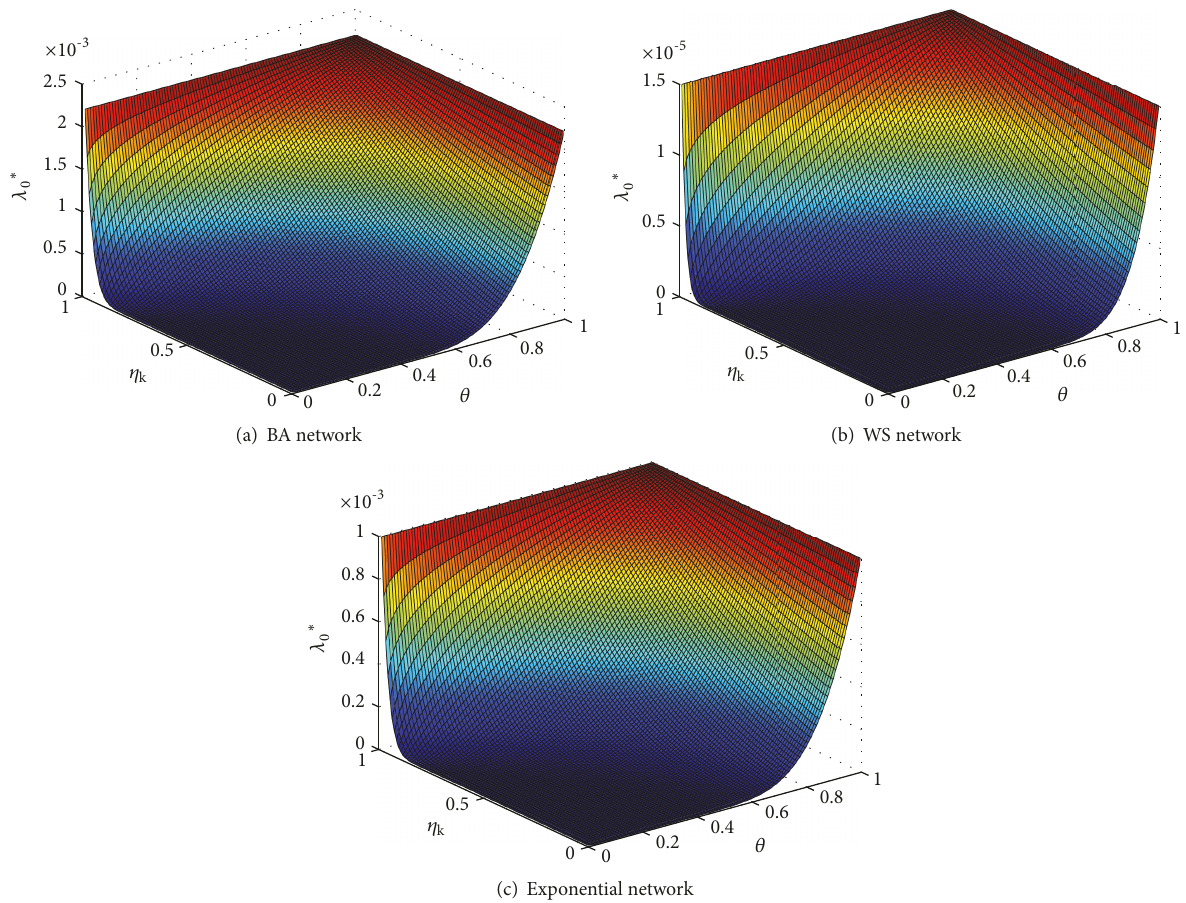
Figure 5: Change rules in the threshold of the rate of health food safety scare behavior diffusion under three network structures: (a) BA network, which exerts the effects of the health food safety information transparency 𝜃 and the degree 𝑘 of health food consumers’ ability to process information 𝜂 𝑘 on the threshold of the rate of health food safety scare behavior diffusion 𝜆 0 ∗ ; (b) WS network, which shows the effects of the health food safety information transparency 𝜃 and the degree 𝑘 of health food consumers’ ability to process information 𝜂 𝑘 on the threshold of the rate of health food safety scare behavior diffusion 𝜆 0 ∗ ; (c) Exponential network, which shows the effects of the health food safety information transparency 𝜃 and the degree 𝑘 of health food consumers’ ability to process information 𝜂 𝑘 on the threshold of the rate of health food safety scare behavior diffusion 𝜆 0 ∗ (where 𝑘 = 1000 and 𝜇 = 0.01